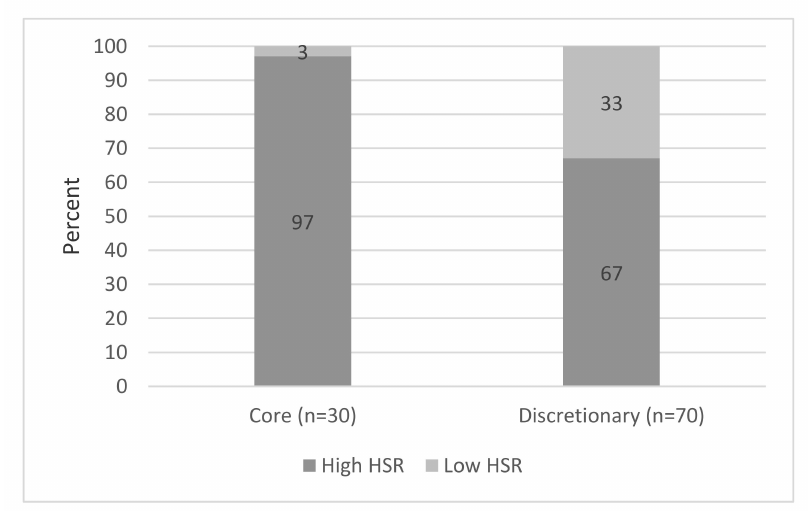
Figure A3. Core and discretionary foods by Health Star Rating (HSR) category ( n =